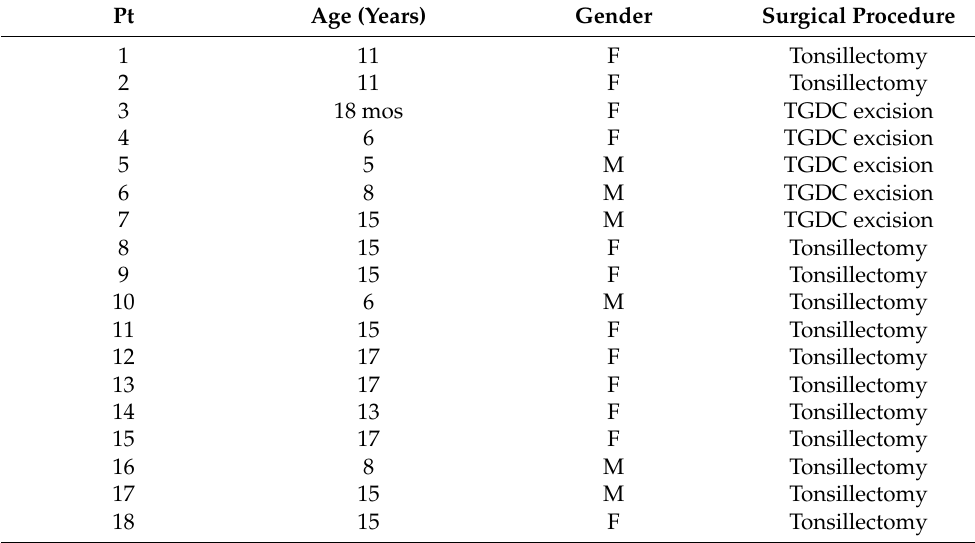
Table 2. Characteristics of the control group.